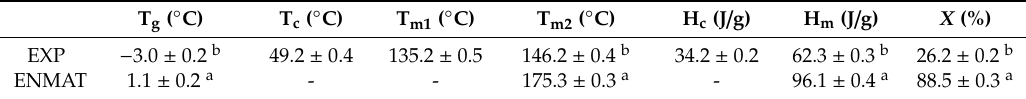
Table 3. Thermal properties of the PHBV purified from R-NF fermented with Hfx.